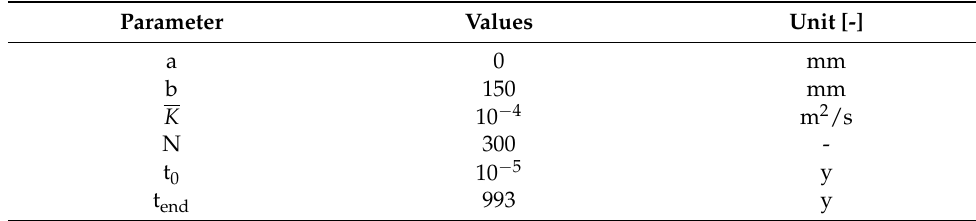
Table 2. Material parameters for FD radionuclides transport.